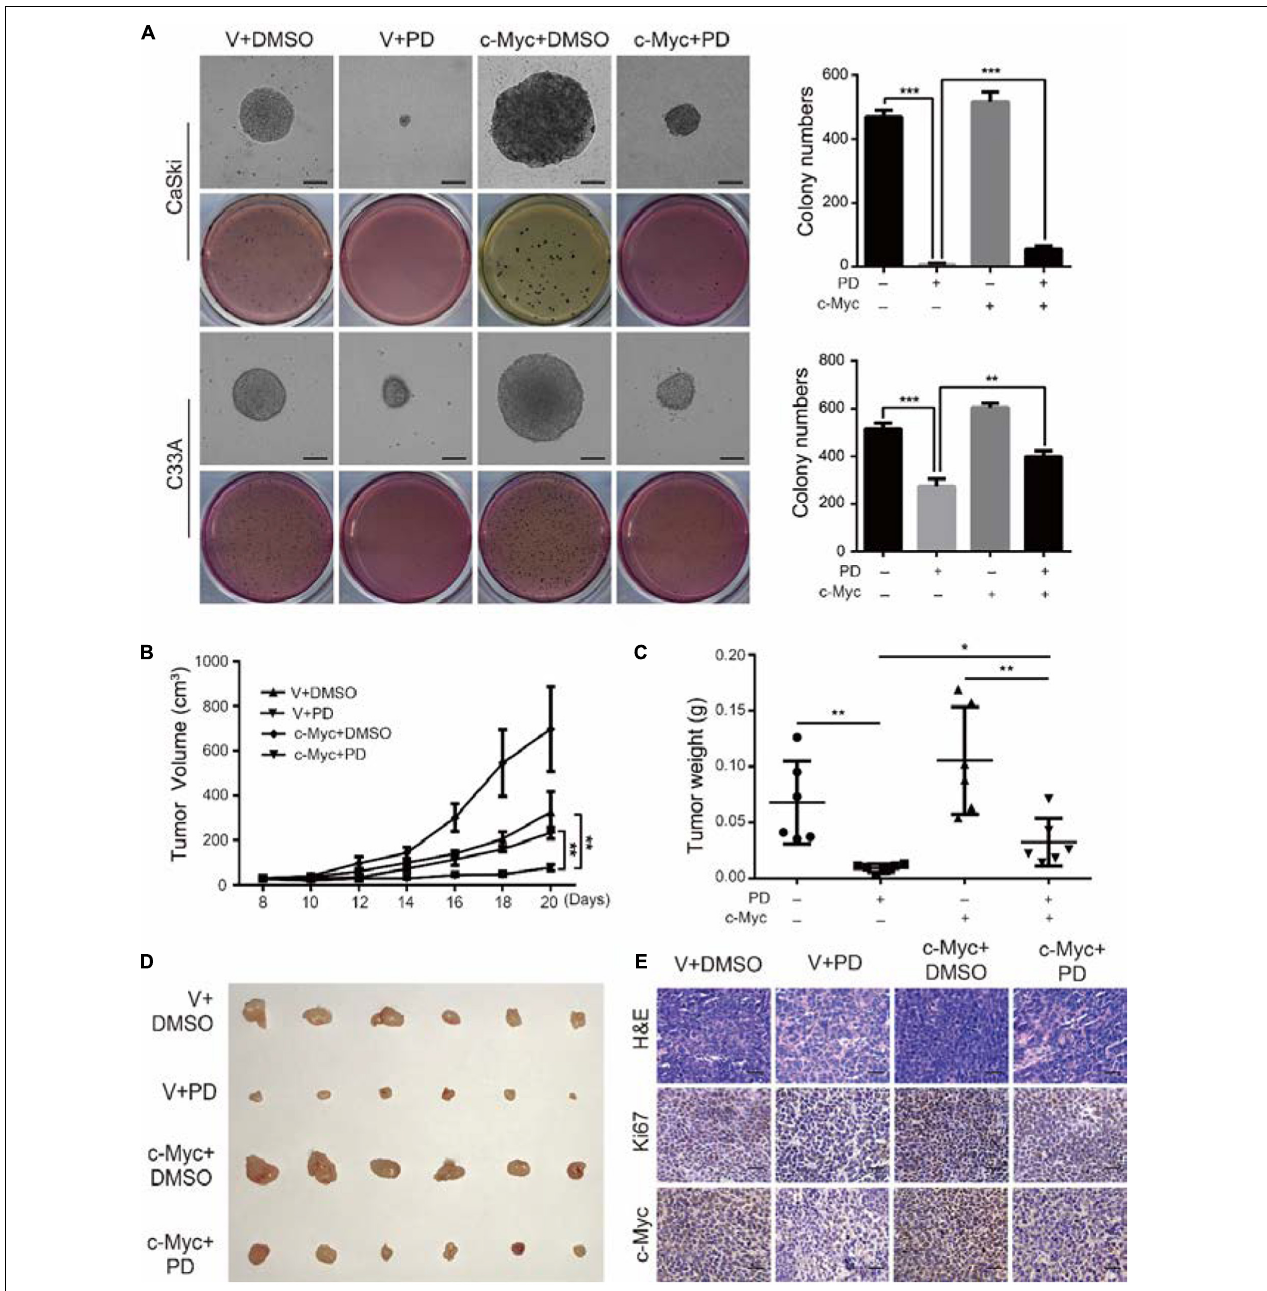
FIGURE 7 | The upregulation of c-Myc relieves the polydatin-induced inhibition of clonogenicity and tumorigenesis. (A) The colony-formation ability of c-Myc-overexpressed cells was detected after treating with DMSO or 200 µ M of polydatin. Scale bar, 100 µ m. Colony numbers in the panel were quantified. (B,C) Tumor volumes and weights of indicated tumors were recorded and analyzed. (D) Photograph of tumors from indicated mice. (E) H&E staining and immunohistochemical (IHC) staining of Ki67 and c-Myc at indicated tumors. Scale bar, 100 µ m. Dimethyl sulfoxide (DMSO) and empty vector (V) were used as control. All data were analyzed using two-tailed Student’s tests. Error bars, ∗ P < 0.05, ∗∗ P < 0.01, and ∗∗∗ P <